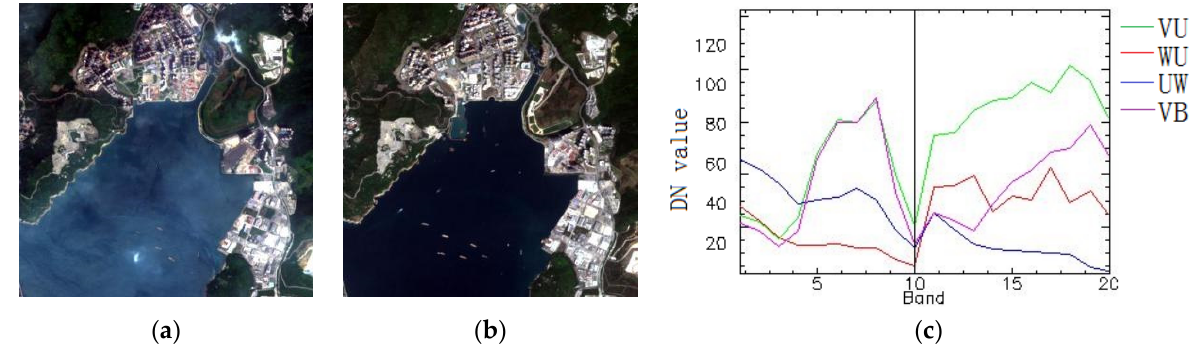
Figure 7. Real Multitemporal image data 1 (wavelength: R: 665 nm, G: 560 nm and B: 496 nm): ( a ) the original Sentinel-2 image in 2016, ( b ) the original Sentinel-2 image in 2018 and ( c ) four changed endmember spectral signature descriptions.